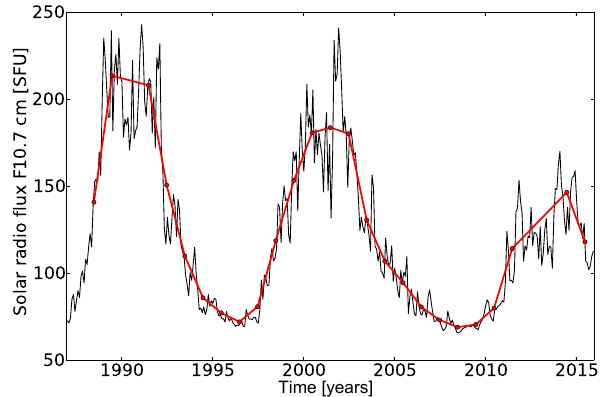
Figure 5. Monthly average values of the solar radio flux F10.7cm. The red dots mark the annual average values corresponding to the times of the GRIPS data points. The data were provided by Natural Resources Canada, Space Weather